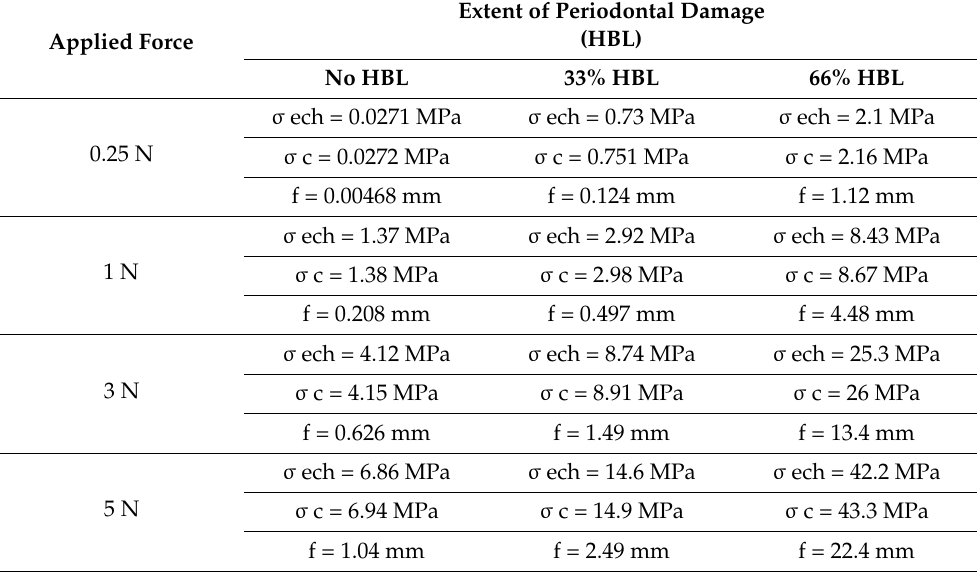
Table 3. Simulation of lingualization in the lower central incisor according to the applied force and extent of periodontal damage.